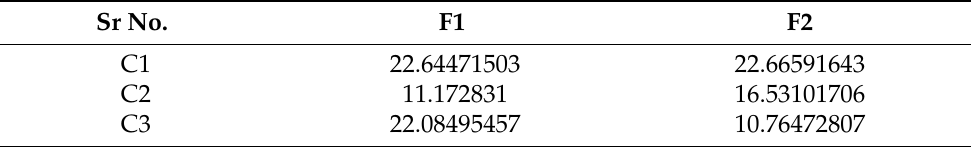
Table 17. The best centroids for Spiral obtained by proposed